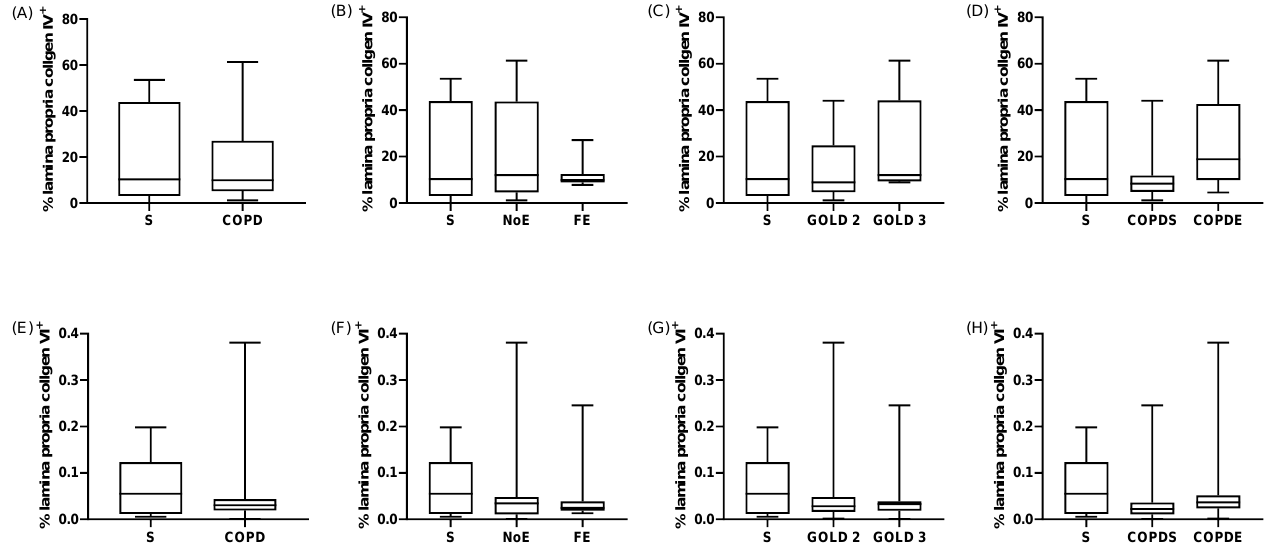
Figure 3. Quantification of collagen 4 and 6 expression. Collagen 4 ( A – D ) and 6 expression ( E – H ) were compared between ( A , E ) COPD patients and smoking controls (S), with further detailed clinical phenotyping in COPD patients based upon ( B , F ) exacerbations, ( C , G ) airflow limitation, and ( D , H ) smoking status. Data presented as median ± range. Comparisons between groups were made by Kruskal–Wallis followed by Dunn’s